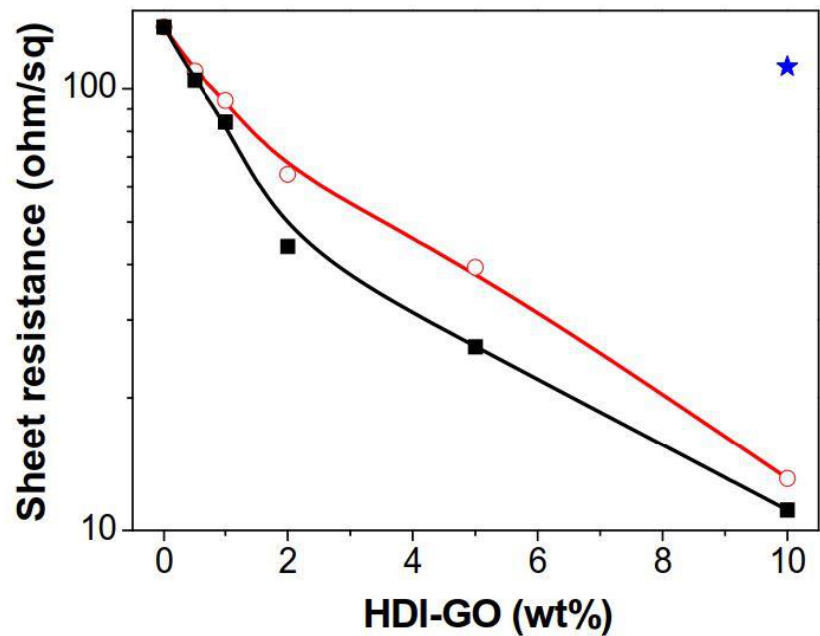
Figure 5. Sheet resistance of PANI nanocomposites reinforced with HDI-GO 6 (solid squares) and HDI-GO 1 (open circles) as a function of the HDI-GO content. Solid lines are guides for the eyes. The blue star corresponds to the PANI/GO (10 wt %) reference composite.